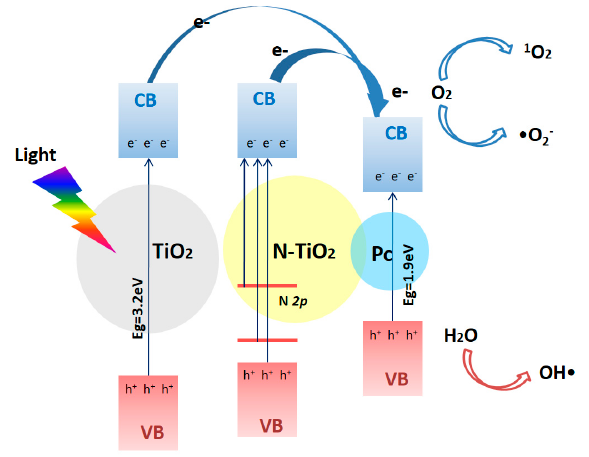
Figure 4. Schematic illustration of a proposed mechanism of ROS production by N-TiO 2 -Pc (or TiO 2 -Pc) under irradiation.